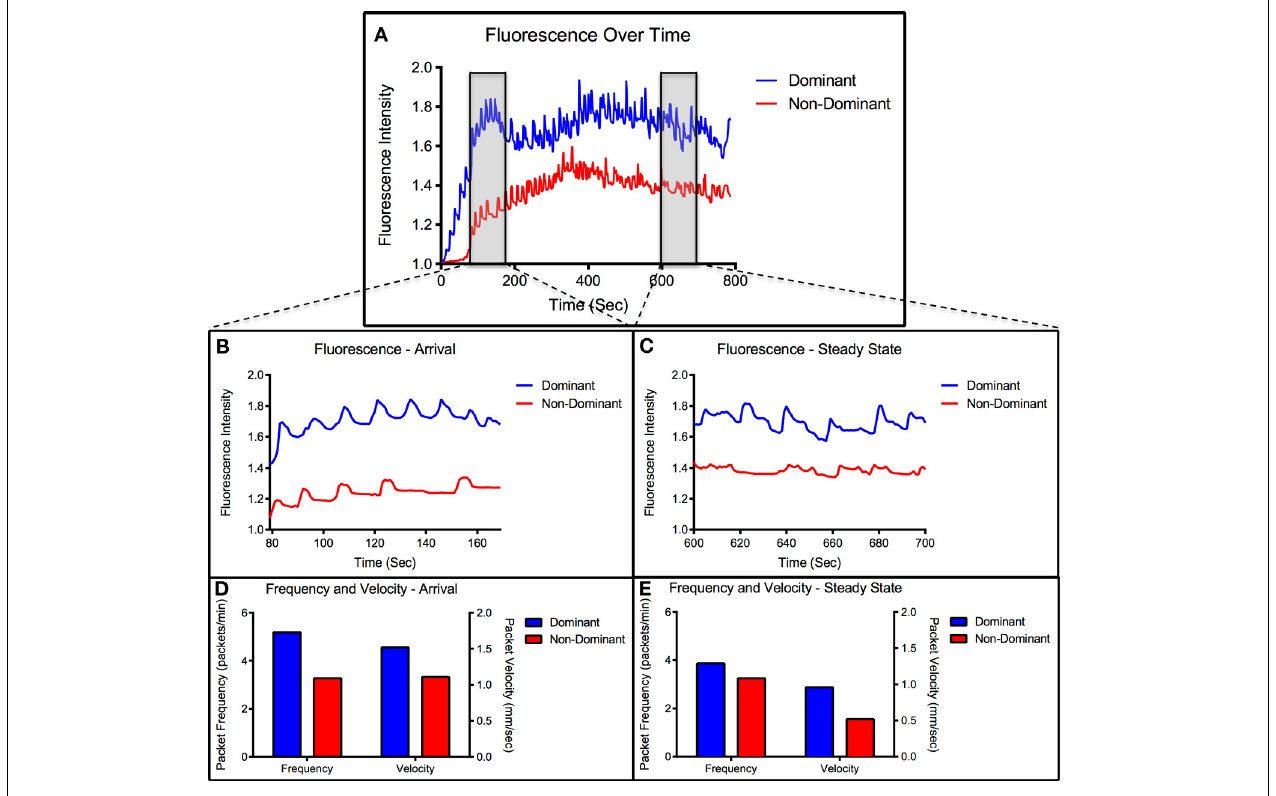
FIGURE 2 | Representative vessel transport characteristics. (A) Representative data set showing fluorescence over time for dominant and non-dominant vessel. Arrival and steady-state segments are highlighted in the gray boxes. (B) Close-up view of intensity signal